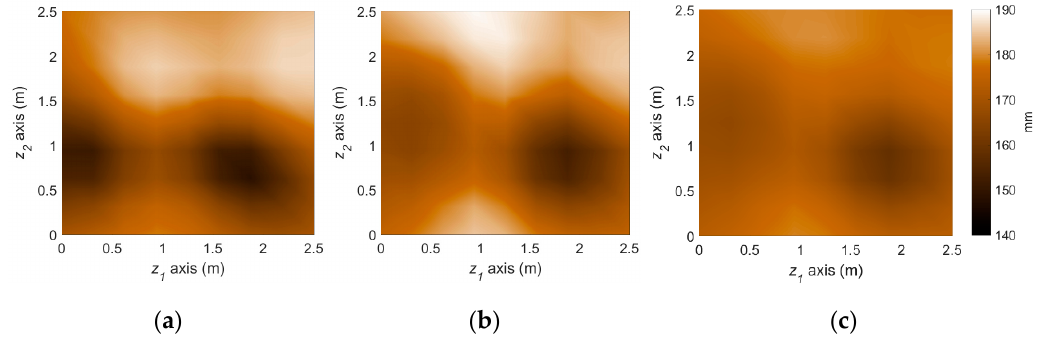
Figure 13. Prediction of deterioration pattern with a dynamic model parameter: ( a ) Reference; ( b ) Particle filter with parameter updating (proposed); ( c ) Particle filter without parameter updating.